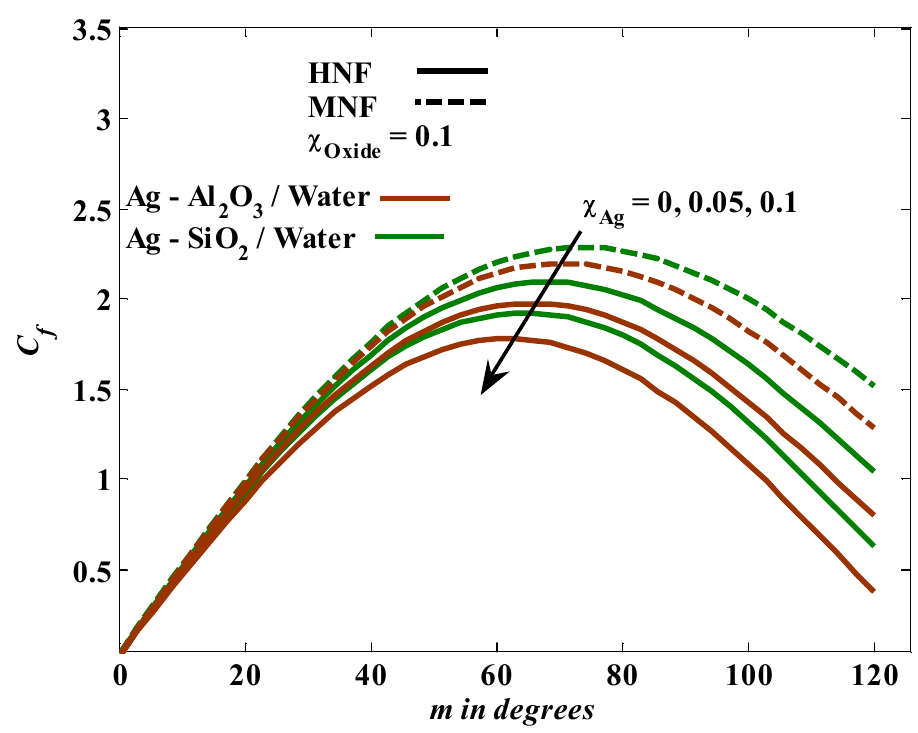
Figure 11. Illustration of χ Ag versus skin friction at fixed values of We = 0.2, R = 0.1, M = 2, & λ = 1. The impact of the thermal radiation factor on temperature and velocity profiles is manifested in Figure 12. Elevating the thermal radiation factor values causes more en- ergy to be imposed inside the Williamson hybrid nanofluid, which raises the velocity and temperature profiles. Figure 13 report the influence of the combined convection pa- rameter on temperature and velocity profiles. It is observed that ascending values of the combined convective factor cause a reduction in the temperature. This also resulted in an improvement in the velocity profiles. In fact, this phenomenon is the result of the enhancement in the buoyant forces due to the increase in the mixed convection values. The effect of rising Weissenberg number values on temperature and velocity is plotted in Figure 14. Intensification in temperatures and curbing in velocity are observed via a higher Weissenberg number. The Weissenberg number is defined as the ratio of relaxation time to retardation time. When the retardation time decreases, an increase in the value of the Weissenberg number occurs, which is accompanied by a decrease in the velocity of the liquid as well as a decrease in the boundary layer thickness. It is clear that the velocity gradient decreases near the surface of the cylinder when the Weissenberg number increases. The increase in this parameter is also accompanied by an increase in the temperature of the host hybrid nanofluid. Figure 15 demonstrate the behavior of both temperature and velocity with the increment in M. Temperature is an increasing map of M, while velocity is a decreasing map of M. This behavior was expected because the increase in the strength of the magnetic field generates a type of force known as the Lorentz force, which raises the temperature of the Williamson hybrid nanofluid fluid and slows it down. In Figure 16, the responses of both temperature and velocity profiles to the increasing volume fraction of the nanosolid are shown. For rising values of the nanosolid volume fraction of Ag, the temperature tends to rise while the reaction velocity is reversed, as its values decrease. The increase in energy transport as χ Ag increases could explain the rising temperature profiles and decreasing velocity. Finally, a noteworthy note made by the results is that regardless of the influencing factors examined in this study, the combination of silver with